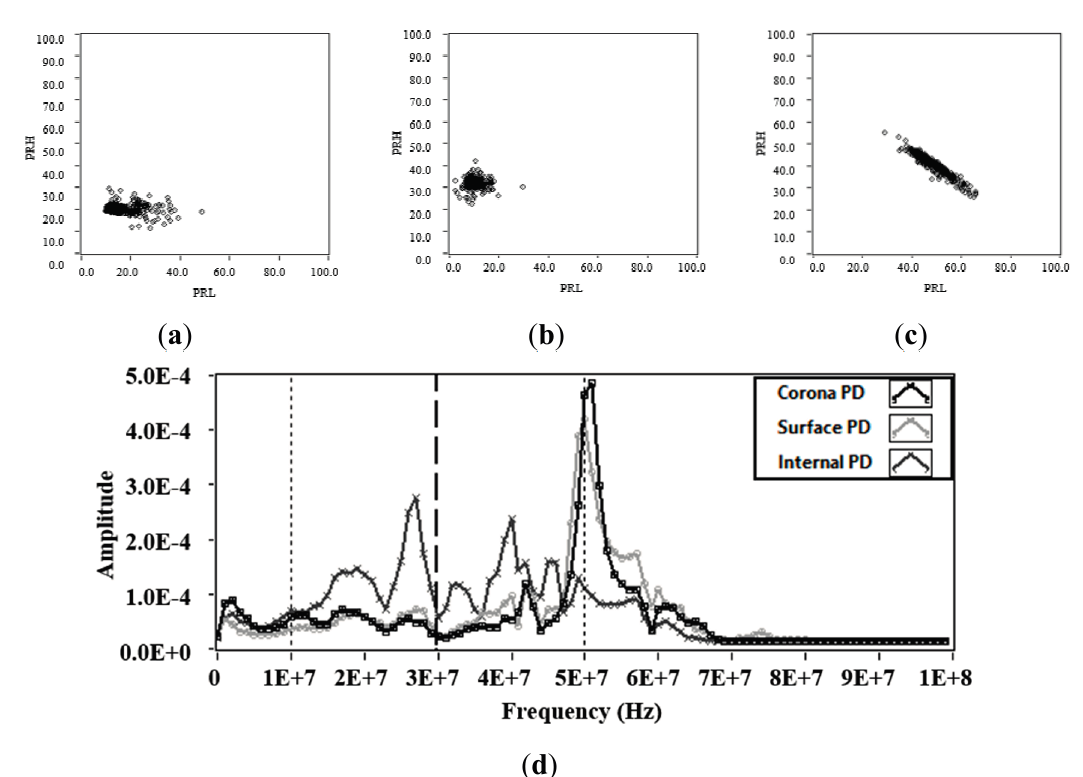
Figure 7. Partial discharges ( a ) Power ratio map for PD in point-plane experimental test object; ( b ) Power ratio map for PD in contaminated ceramic bushing; ( c ) Power ratio map for PD in pierced insulating sheets; ( d ) Average spectral power of the PD signals obtained with the three test